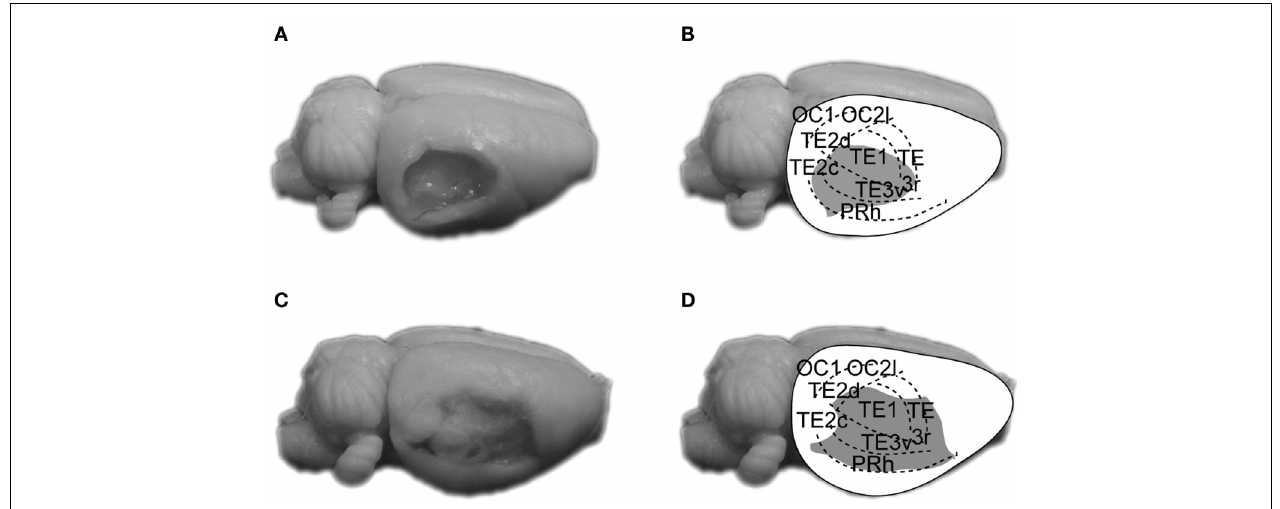
FIGURE 2 | Photographs and reconstructions of representative small (A,B) and large aspiration lesions of AC (C,D). The parcellation of AC is based on that of Zilles et al. (1990). OC, occipital cortex; PRh, perirhinal cortex; TE1, primary AC; TE2/TE3, secondary